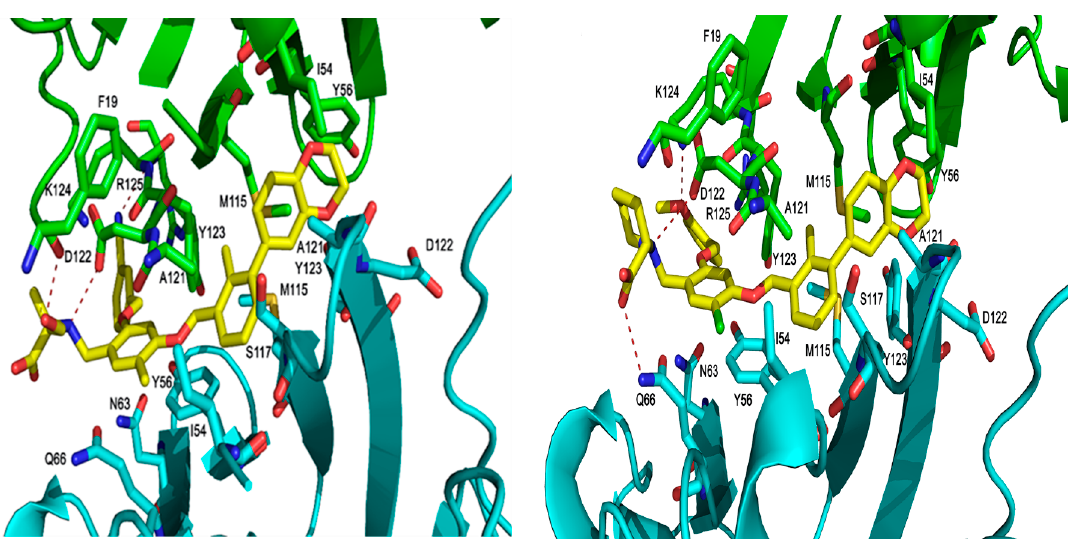
7 of 15 Figure 6. Docking enrichment plot of false positive vs. sensitivity in the 5NIU model. 2.2. Binding Interactions of PD-L1/inhibitors After the validity of the glide dock method was confirmed by the aforementioned methods, we can confidently use the docked poses to identify PD-L1/inhibitor interactions. To design new molecules with the desired potency, it is important for the designed molecules to maintain the proper interactions with essential residues in the binding pocket. Thus, it is very important to identify critical binding residues for effective PD-L1 binding. The PD-1/PD-L1 complex inhibitors bind to PD-L1 through the PD-1 interacting surface site